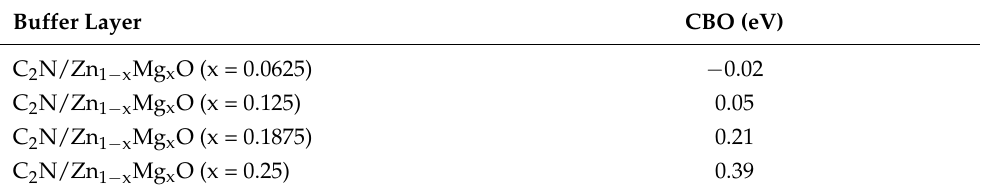
Table 4. CBO of C 2 N/ZMO